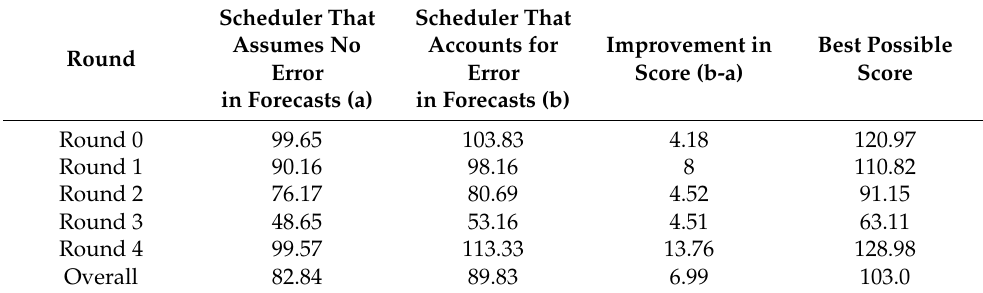
Table 8. Improvement in the weekly score from the scheduler with imperfect